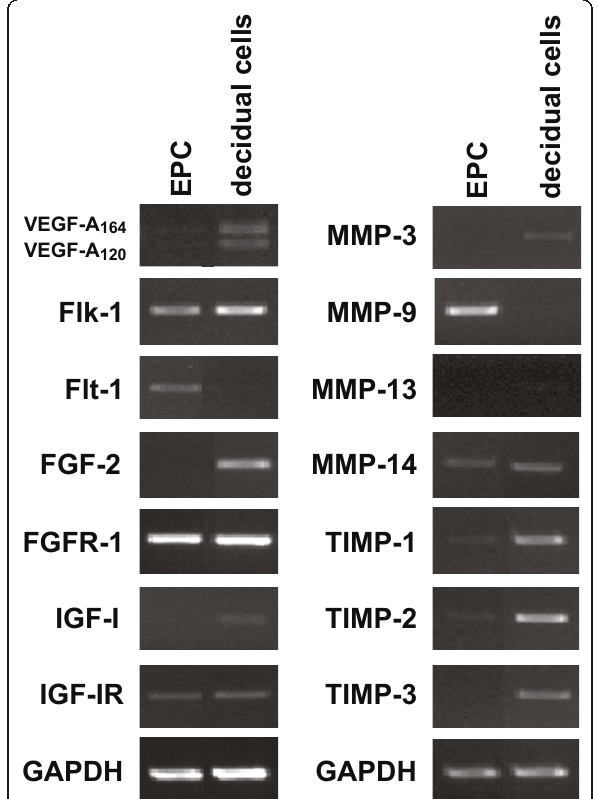
Figure 4 Expression profiles of angiogenesis- and matrix remodeling-related genes in cultured EPCs and decidual cells . EPCs and decidual cells were isolated from decidual capsules at 7.5 days p.c. Decidual cells (5 × 10 5 cells/well in 6-multiwell plates) and EPCs (10 EPCs/well in 6-multiwell plates) were cultured in DMEM containing 10% FBS for 2-5 days, respectively. Total RNA was isolated, reverse-transcribed, and the indicated sets of genes associated with angiogenesis (left panel) and tissue remodeling (right panel) were analyzed by RT-PCR (25 cycles for VEGF-A, Flk-1, Flt-1, MMP-3, MMP-9, MMP-14, TIMP-1, TIMP-2, TIMP-3 ; 30 cycles for FGF-2, FGFR-1, IGF-I, IGF-IR, MMP-1 ). GAPDH (25 cycles) was used as an internal control. The data are representative of three independent